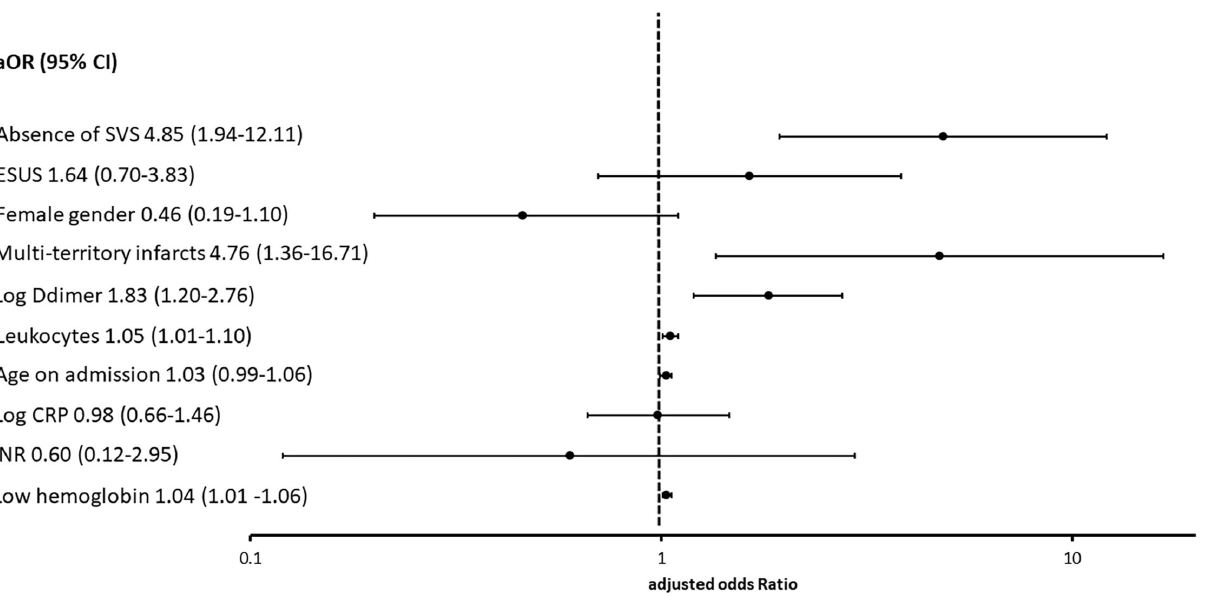
FIGURE 2 | Association between active malignancy, neuroimaging, and blood biomarkers in the multivariable logistic regression. According to the primary goal of this study and previous evidence, adjusted odds ratios (aOR) and their 95% confidence intervals (95% CI) for the association between active malignancy and preselected biomarkers are summarized in this figure. Absence of SVS showed the strongest association with the presence of active malignancy, followed by multiterritory infarcts. CRP, C-reactive protein; ESUS, embolic stroke of undetermined source; INR, international normalized ratio; SVS, susceptibility vessel sign.